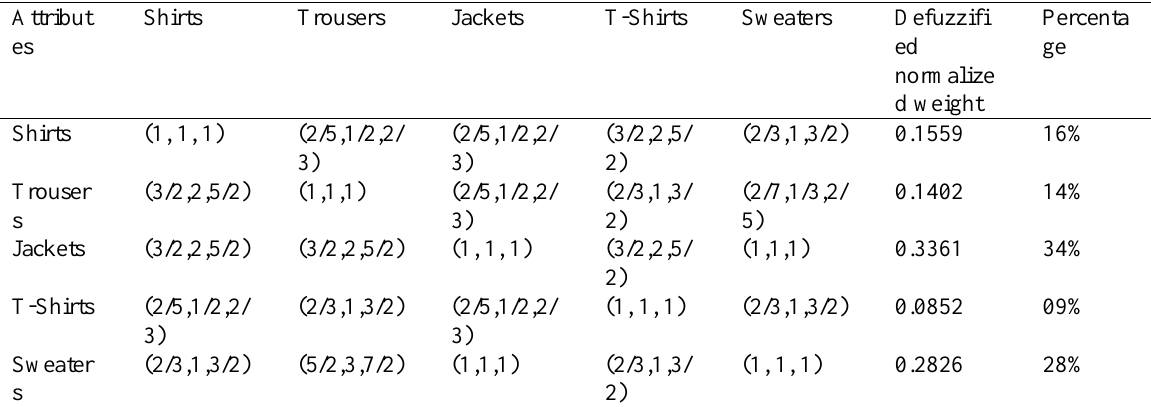
Table 9. The fuzzy comparison matrix for the “demand of buyers” criteria,